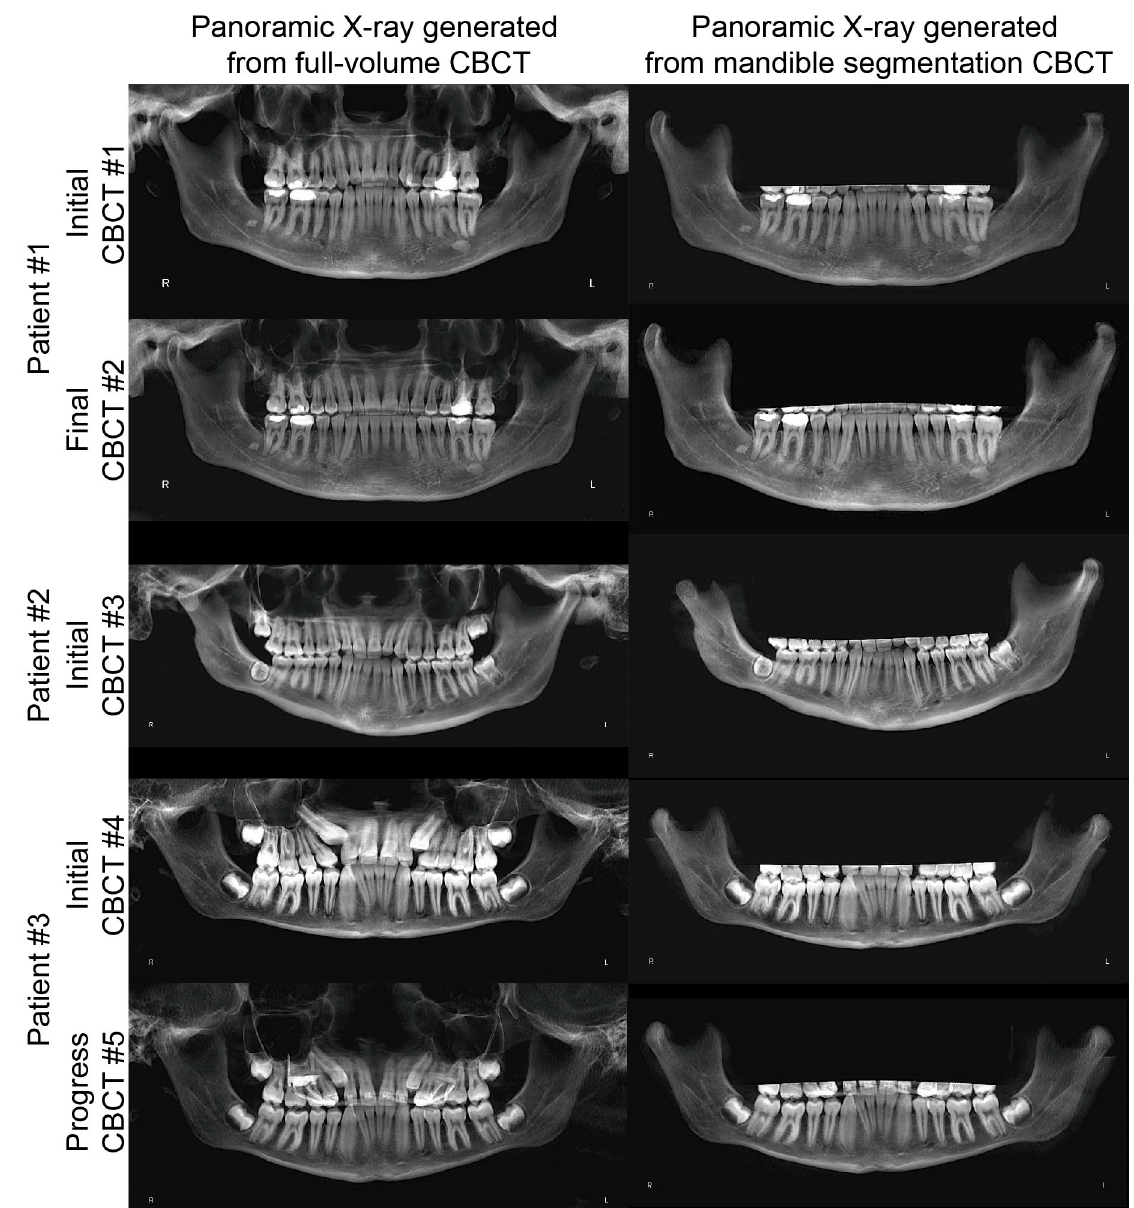
Figure 4. Comparison of the panoramic radiographs generated from the full-volume CBCT and those from the segmented mandible CBCT.